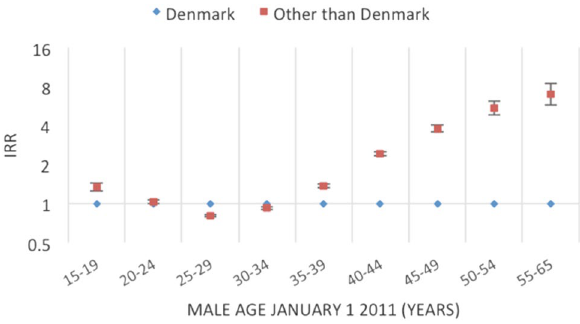
Figure 2. Incidence rate ratios (IRR) of fathering a child according to place of birth 1 and age 2 . Men aged 15–65 years living in Denmark January 1, 2011 to December 31, 2015. 1 Place of birth was categorised as: Denmark or other than Denmark. 2 Age groups according to the man’s age by January 1,